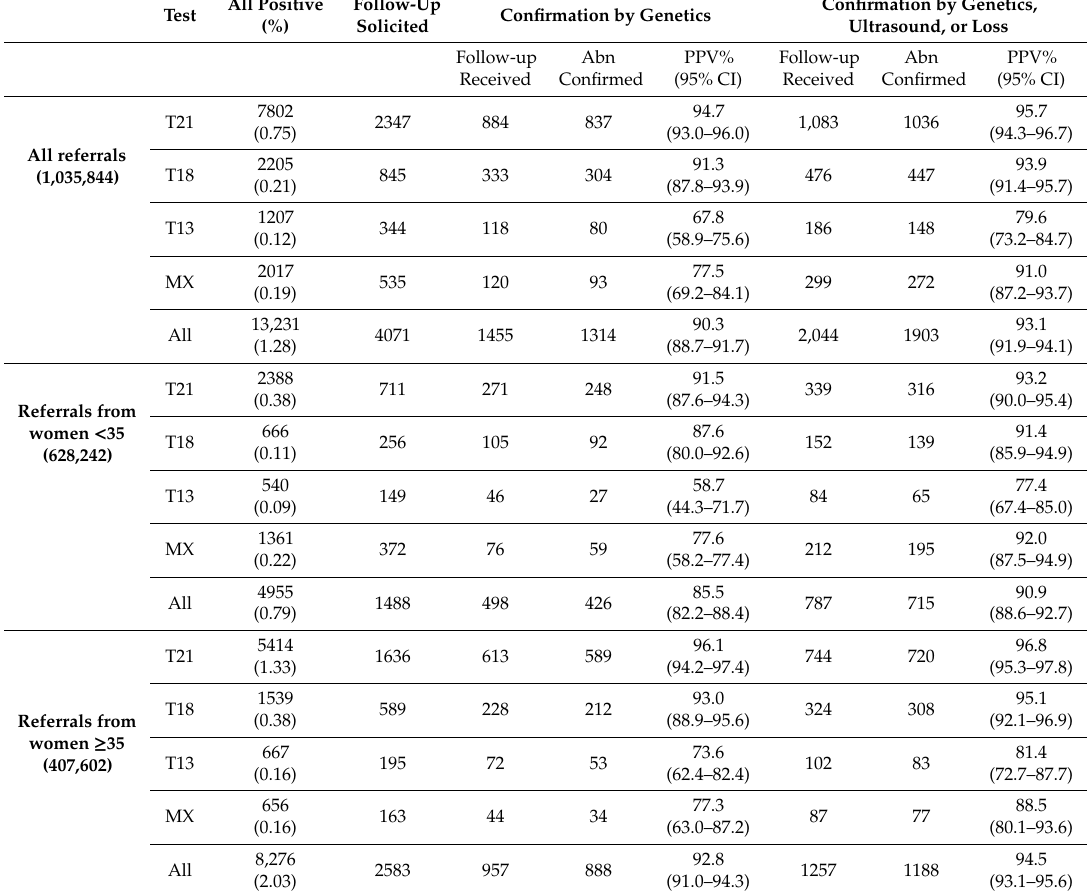
Table 1. Overall PPVs for cases with follow-up information in the 4-year study